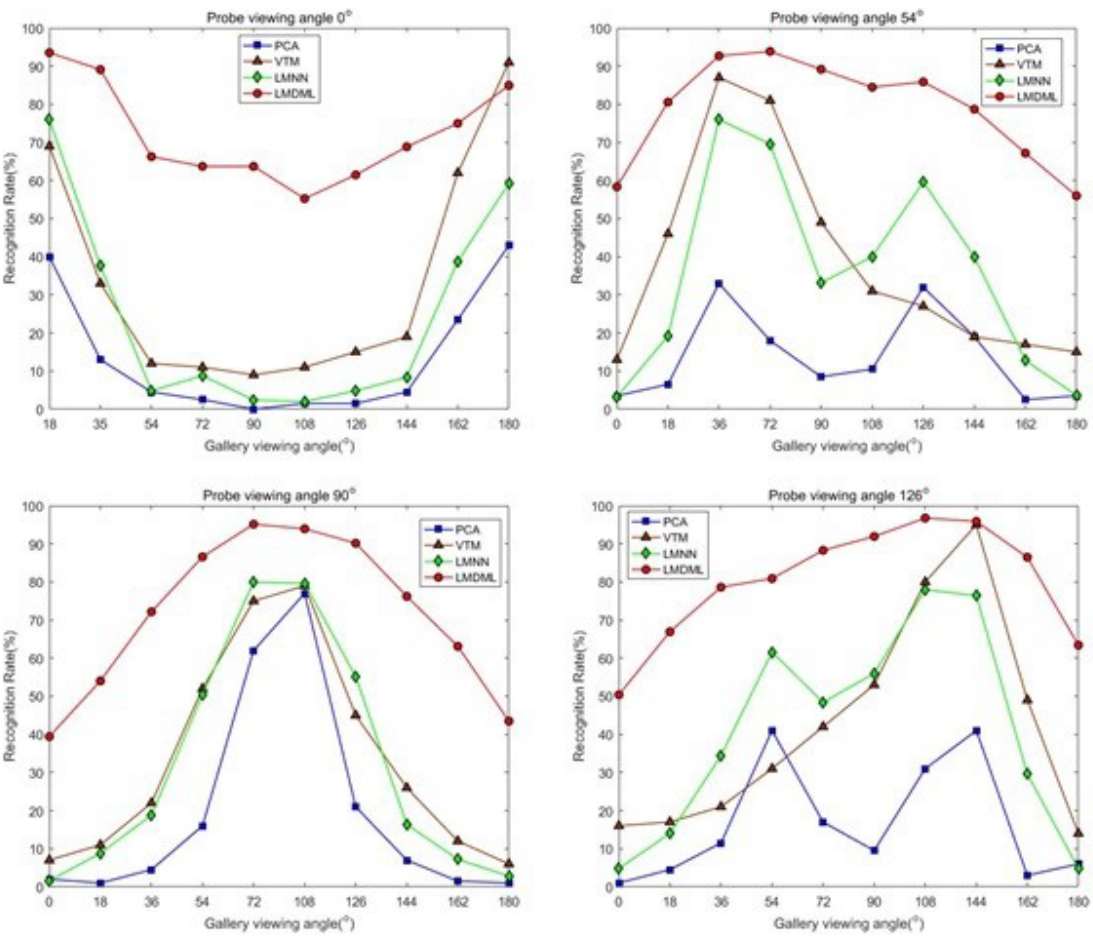
Figure 11: Comparison with PCA, VTM and LMNN at different probe viewing angles.